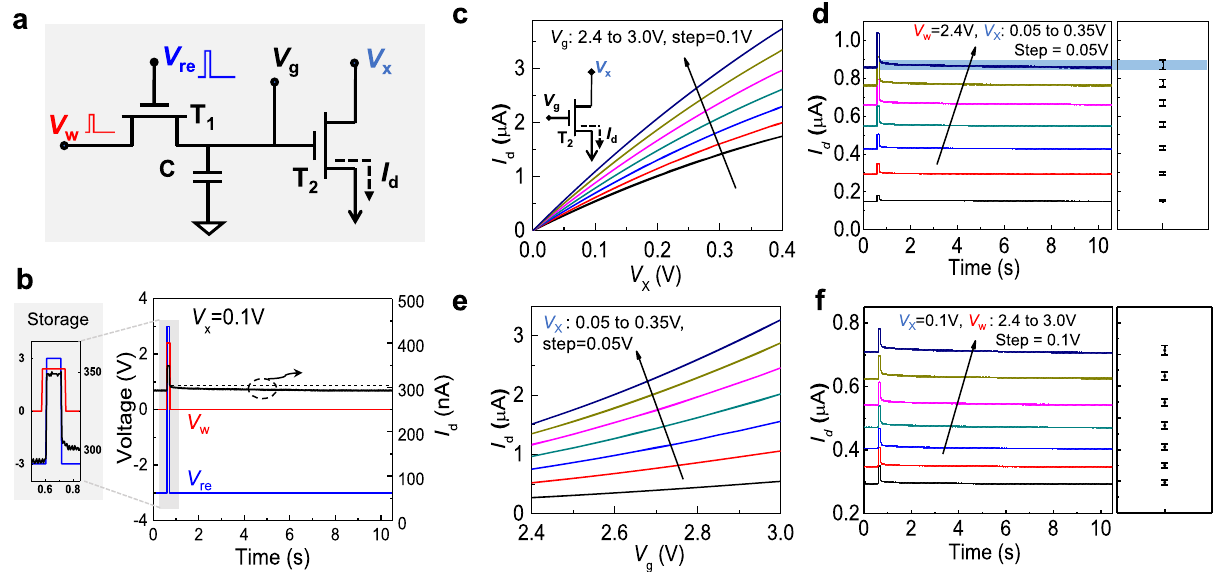
Fig. 3 Characterization of the 2T – 1C unit cell. a Schematic diagram of the circuit used to gather measurements from a 2T – 1C unit cell. b A complete storage and calculation operation for a 2T – 1C unit. The input voltage ( V w , V re , V x ) and drain current ( I d ) are shown vs. measurement time for a 10 s cycle. The magni fi ed inset shows details of the refresh operation. c The output characteristics for T 2 with V g ranging from 2.4 to 3 V in 0.1 V increments. d Drain current I d in T 2 with V x ranging from 0.05 to 0.35 V, where V w = 2.4 V. The bars in the right panel indicate the variation of I d for each curve after T 1 is turned off. e Transfer characteristics of T 2 with V x ranging from 0.05 to 0.35 V in 0.05 V increments. f Drain current I d in T 2 with V w ranging from 2.4 to 3 V, where V x = 0.1 V.